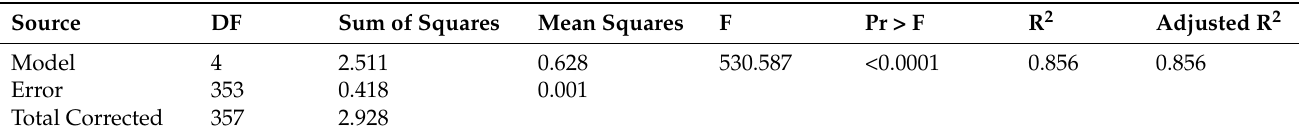
Table 4. Statistical evaluation of XLSTAT model summary for the effluent WWQI.